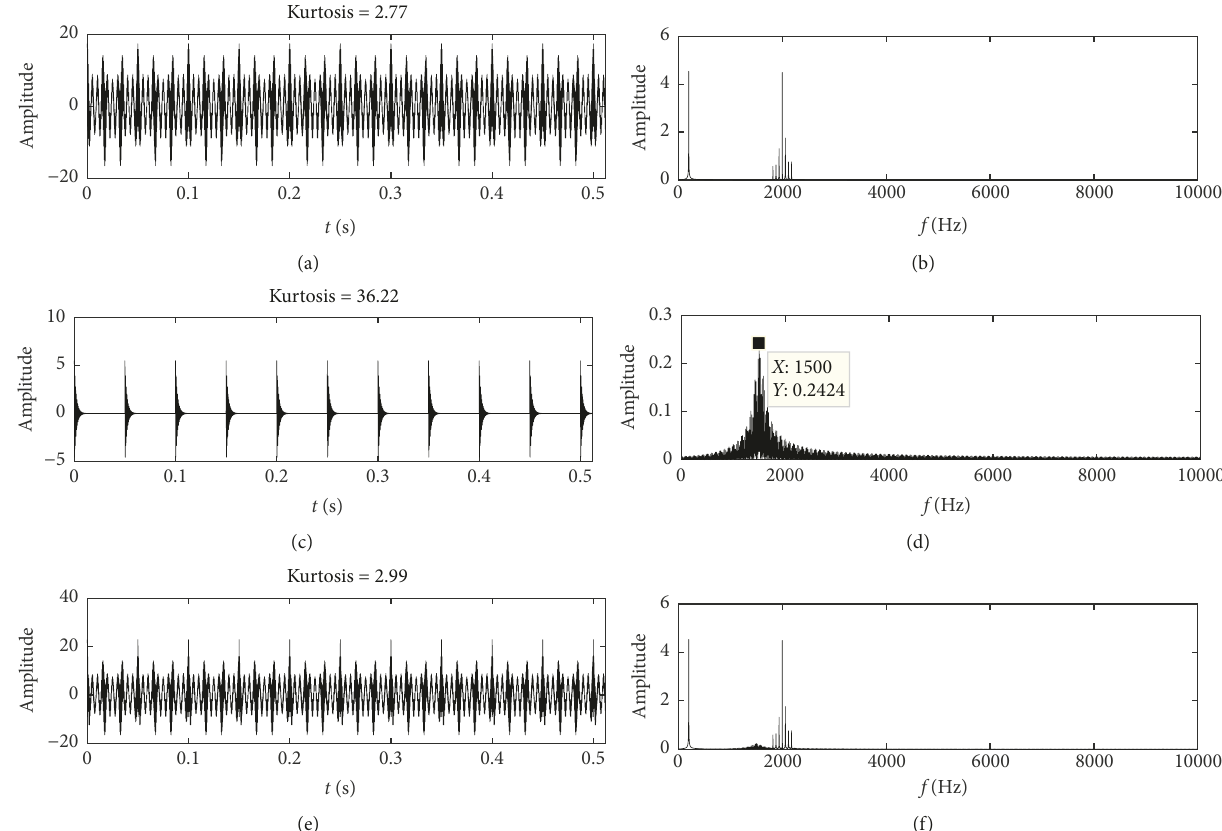
Figure 1: The signal and its spectrum. (a) is the signal, (c) is the impulsive signal, and (e) is the signal added with the impulsive signal. (b), (d), and (f) are the spectrum of corresponding (a), (c), and (e).